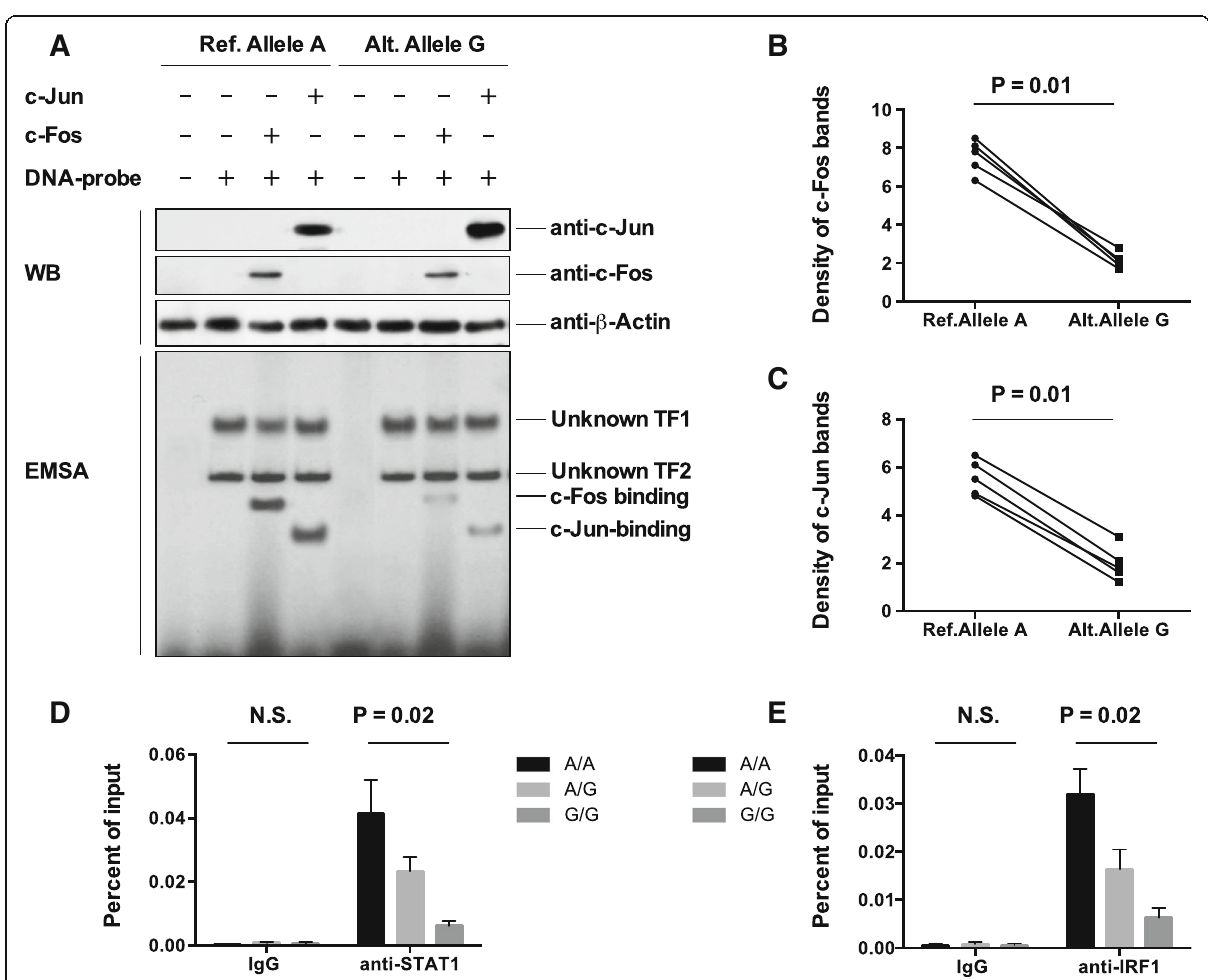
Fig. 2 The risk allele of the variant binds AP-1 subunits with reduced affinity. a A representative figure from three independent western blotting experiments demonstrated the expression of the AP-1 subunits, c-Fos, and c-Jun in fibroblast cells. EMSA revealed that multiple nuclear protein complexes bind to the variant region in which the risk allele of the variant results in reduced binding of the AP-1 subunits. b and c We performed densitometric quantification of AP-1 subunits binding in independent experiments for c-Fos ( b ) and c-Jun cells ( c ). Statistical comparisons were made using paired Student ’ s t-test. d and e ChIP-qPCR was performed using fibroblast cell lines carrying different genotypes of the variants (AA, AG, and GG). ChIP was performed with antibodies specific against c-Fos and c-Jun subunits, respectively, followed by qPCR with primers neighboring the variant rs12905203 region. Statistical comparisons were made using one-way